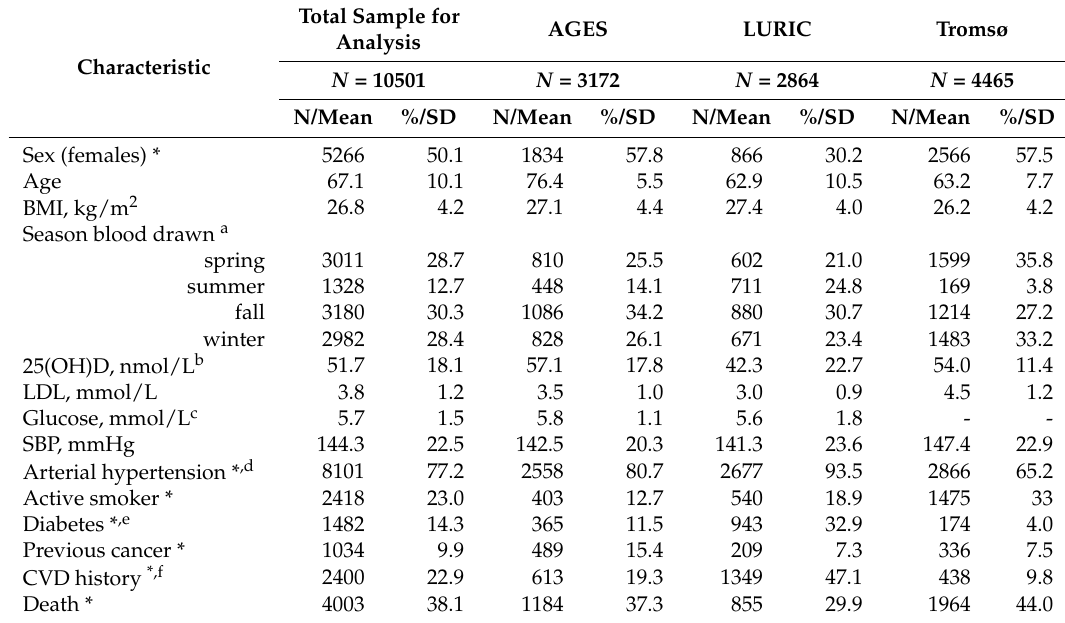
Table 1. General characteristics of the three individual cohorts and the combined